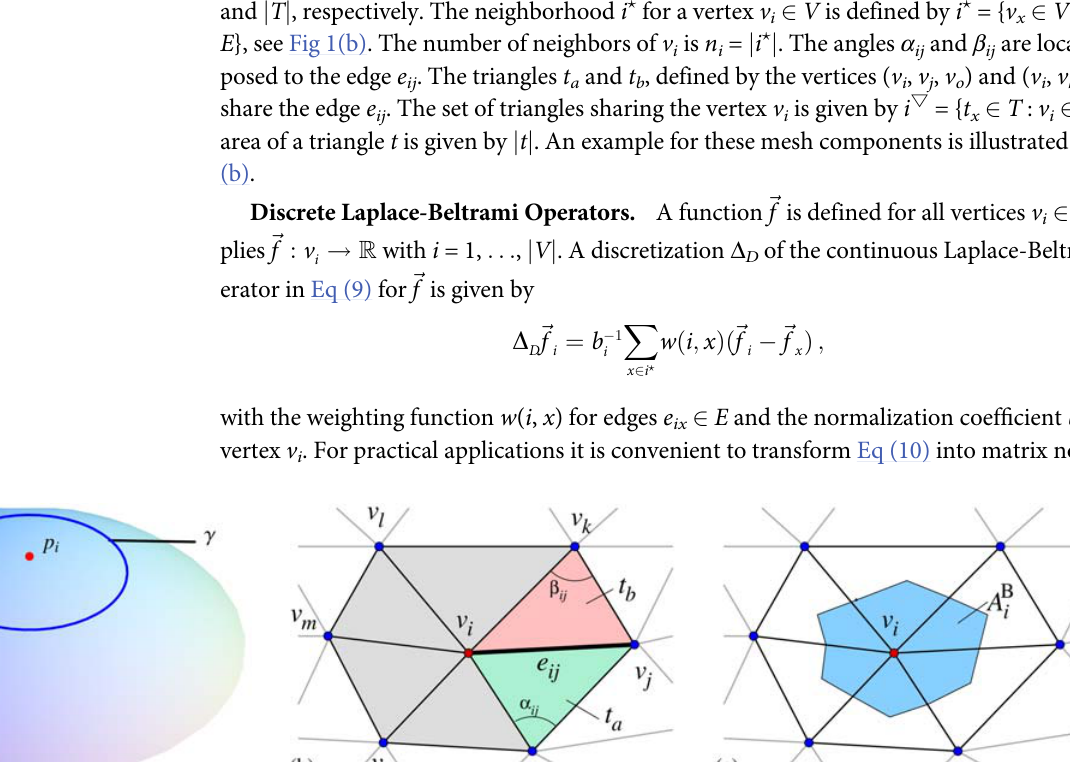
of vertex v i consists of the vertices { v x 2 V : e ix 2 E }. Either the length of e ij or the size of the two angles α ij and β ij opposed to the edge e ij are used to estimate the weight w ( i , j ) for e ij . The two triangles t a and t b both share the edge e ij ; (c) the area of the barycell A B i for the vertex v i